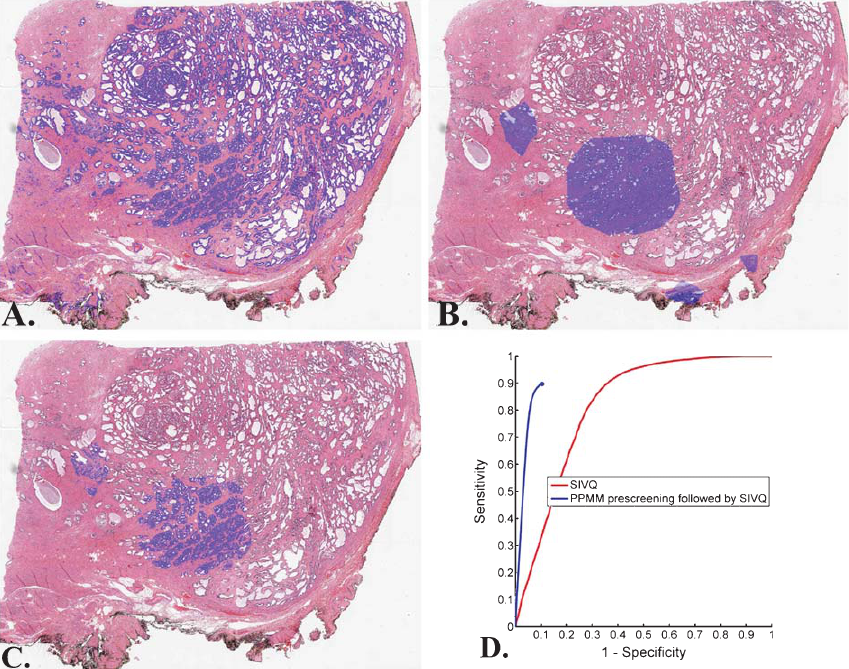
Fig. 4. SIVQ, PPMM, PPMM-SIVQ analysis of sample #3. Using SIVQ, a ring vector was selected to identify the prostatic epithelium. The resultant thresholded heatmap is shown in Panel A. Nearly all the epithelium was identified. The same specimen was then analyzed with PPMM. The resultant thresholded heatmap (binary mask) is shown in Panel B. PPMM identified 3 of 4 tumor foci. The algorithm cascade of PPMM followed by SIVQ was then used to analyze the specimens. The malignant epithelium within the majority of 3 of the 4 tumor foci was identified and annotated in Panel C. To quantitatively assess and compare the performance of SIVQ to PPMM-SIVQ, an ROC curve was generated and shown in Panel D (SIVQ is red, PPMM-SIVQ is blue). PPMM-SIVQ far exceeds the performance of SIVQ alone. (Colours are visible in the online version of the article;